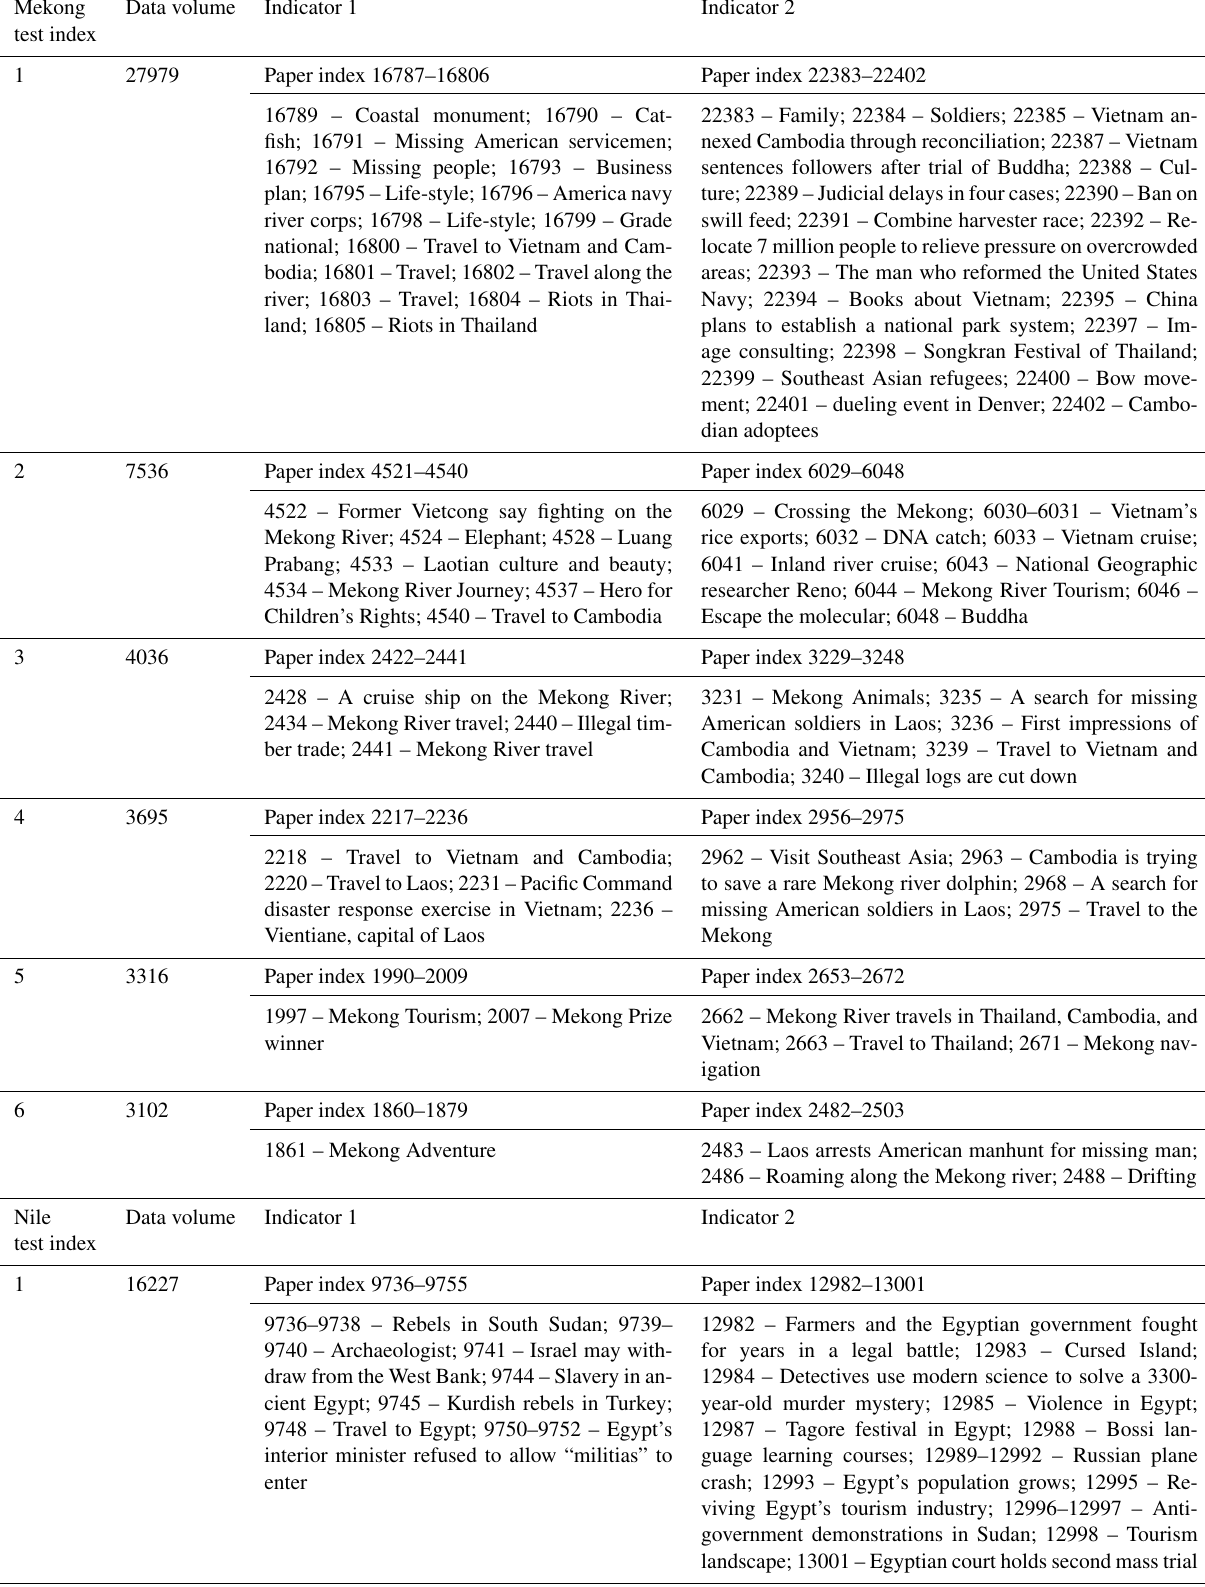
Table A2. Recording of potential irrelevant topics for the Mekong, Nile, and Jordan rivers.